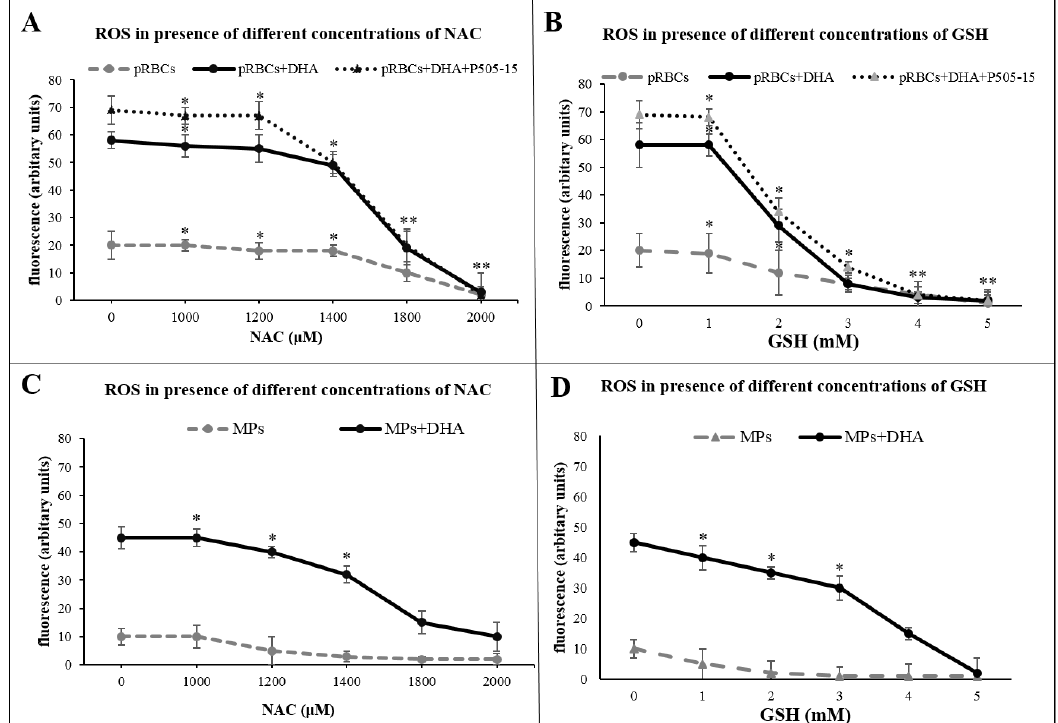
Figure 5. ROS production was performed using the probe CM-H2DCFDA in pRBCs pretreated with/without P505-15 (0.5 µΜ) and DHA (200 µΜ) and their MPs for 24 h at different concentrations of N -acetyl- l -cysteine (NAC) ( A , C ) and GSH (Glutathione) ( B , D ). Significant di ff erences between untreated DHA-RBCs / MPs and pRBCs / MPs at * p < 0.05, ** p <